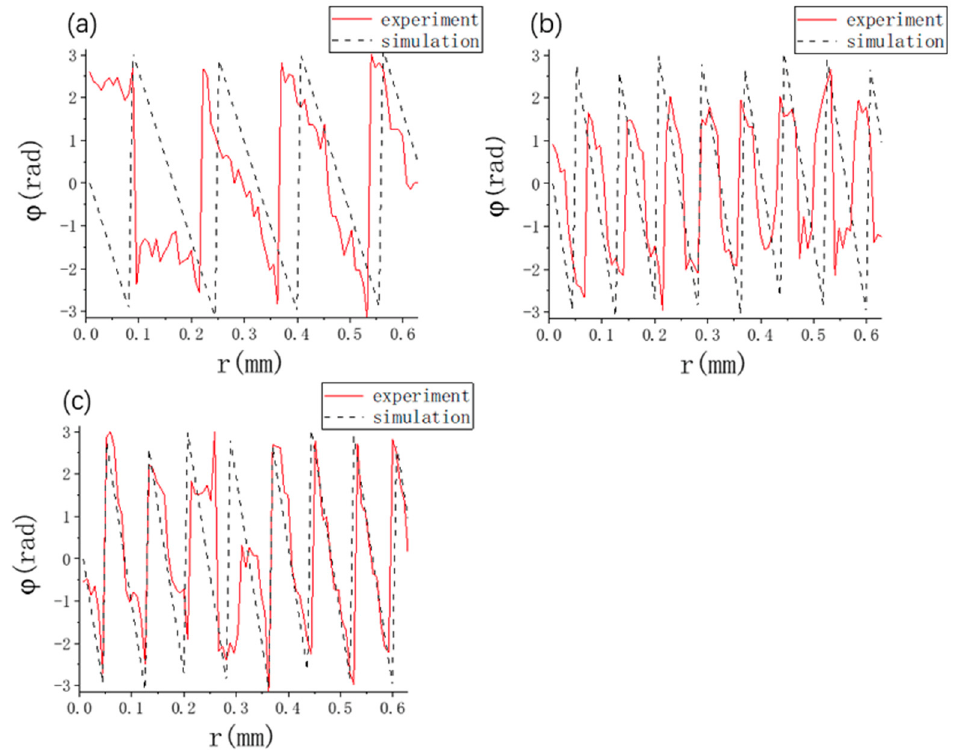
Figure 5. The phase profile along the radial direction. The base angle of the axicon is ( a ) 0.5 degree; ( b ) the first 1 degree; ( c ) the second 1 degree.